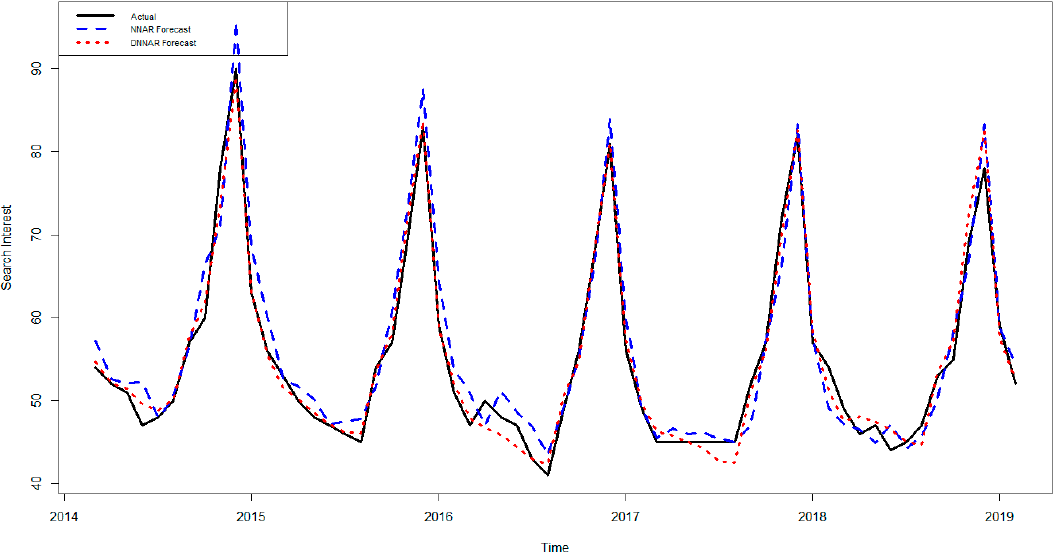
Figure 12. Out-of-sample forecasts for “Burberry” fashion consumer Google Trends at h = 1